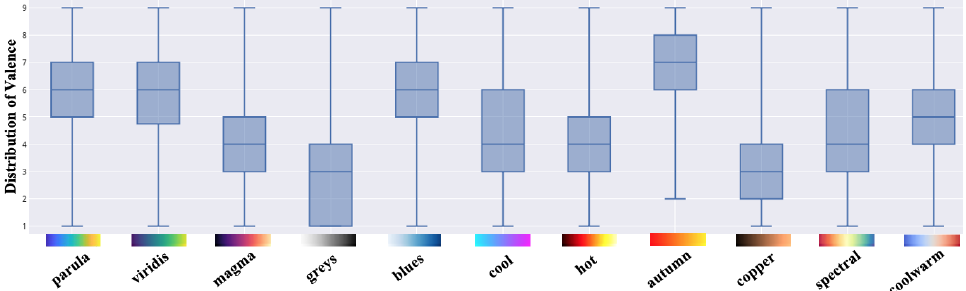
Figure 8. The individual distribution of the affect for the 11 colormaps in the dimension of valence.